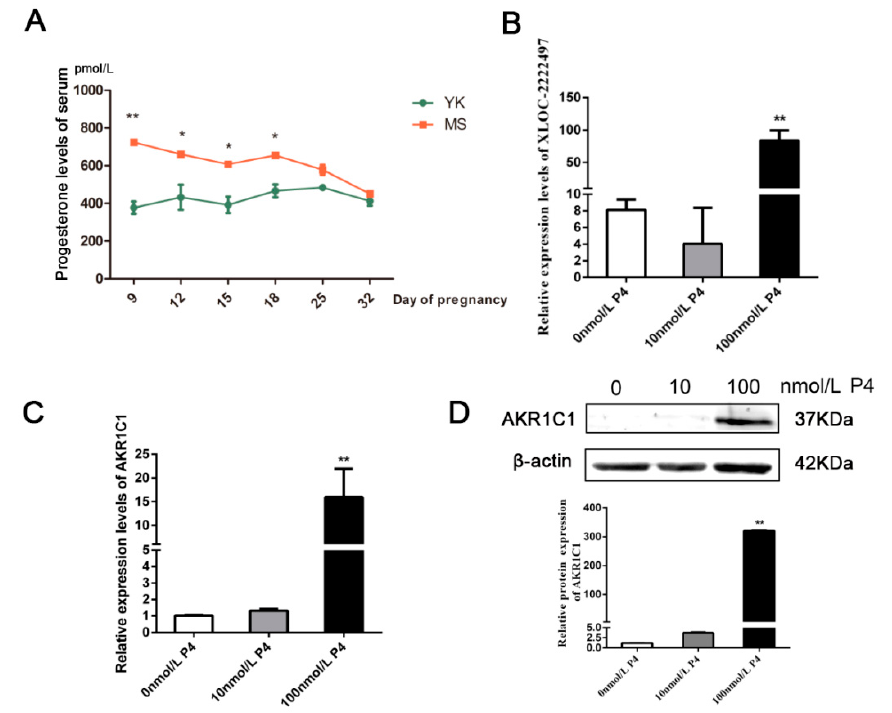
Figure 6. Progesterone measurement and regulation on XLOC-2222497 and AKR1C1 . ( A ) Progesterone levels in serum of Meishan and Yorkshire pigs at di ff erent pregnancy stages. * represents p < 0.05, ** represents p < 0.01,. ( B ) Expression levels of XLOC-2222497 after the treatment of progesterone in porcine endometrial epithelium cells. ** represents p < 0.01. ( C ) RNA expression levels of AKR1C1 after the treatment of progesterone in porcine endometrial epithelium cells. ** represents p < 0.01. ( D ) Protein expression levels of AKR1C1 after the treatment of progesterone in porcine endometrial epithelium cells. Down diagram: quantification of Western blot results, ** represents p < 0.01.